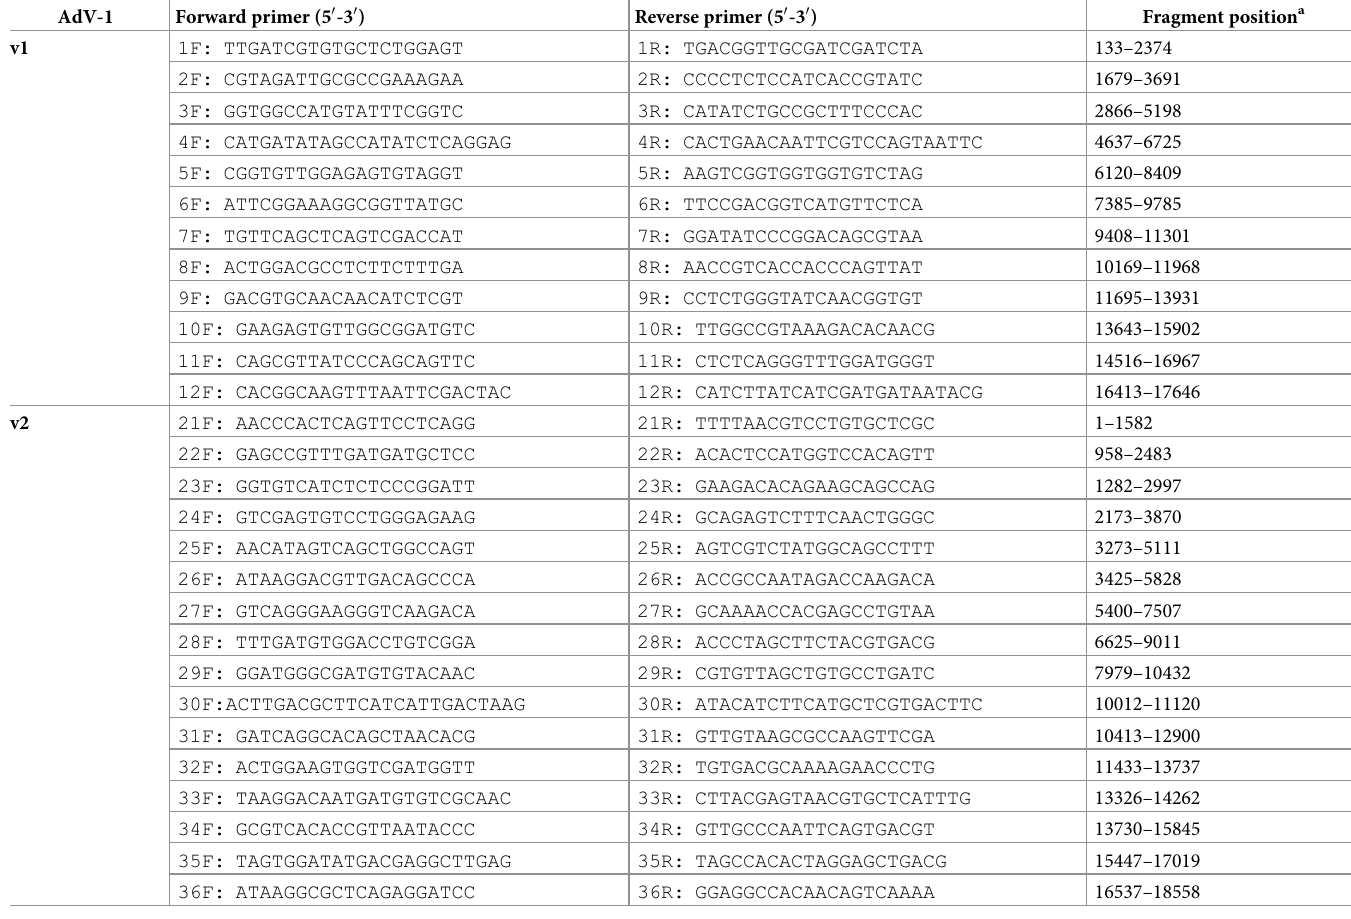
Table 1. Oligonucleotide primers used for overlapping RT-PCR amplification to determine nucleotide sequences of the AdV-1 variants. AdV-1 Forward primer (5 0 -3 0